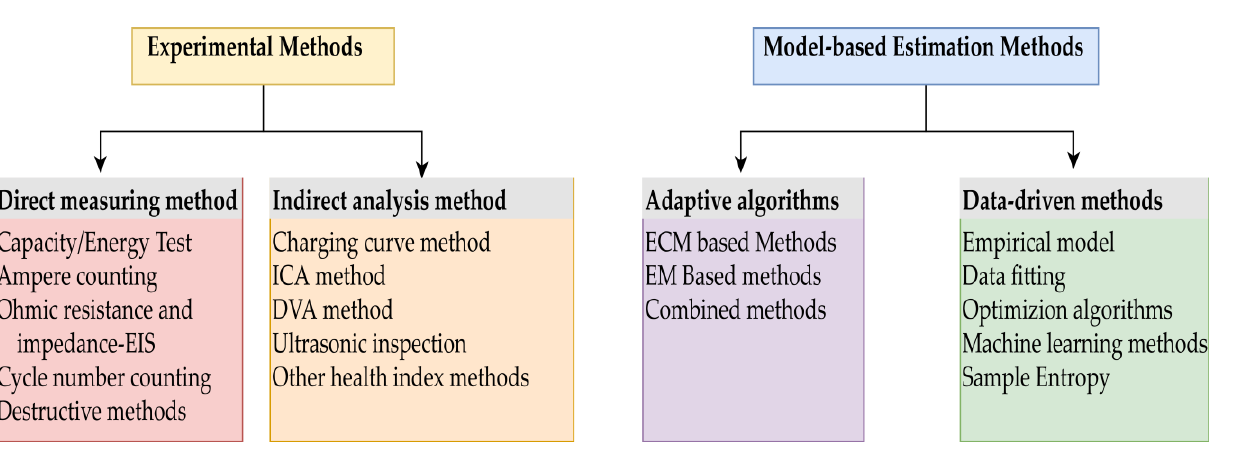
Figure 17. Different SOH estimation approaches.